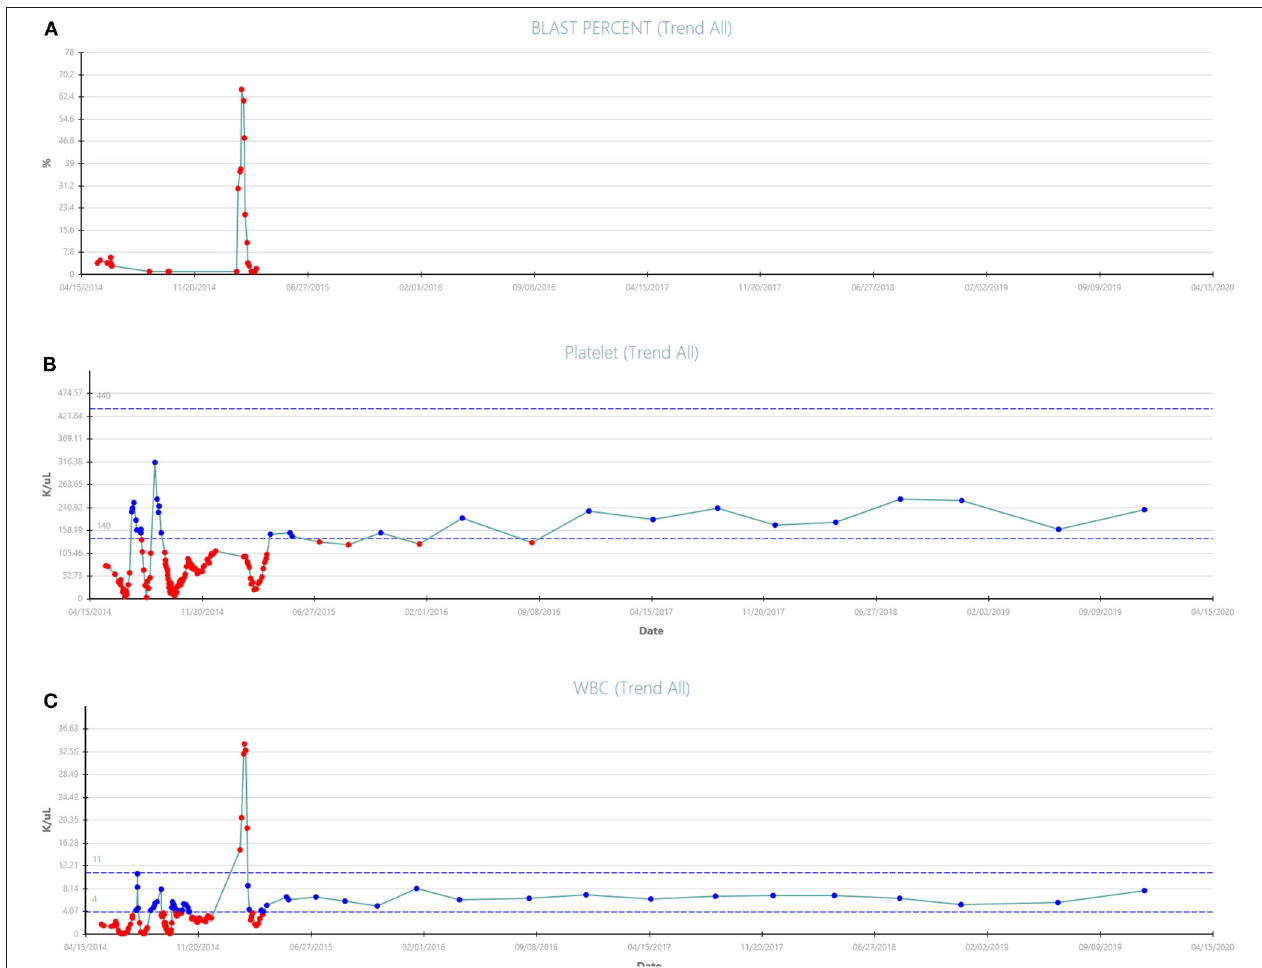
FIGURE 2 | (A–C) Updated trend of blast percentage, white blood count, and platelets from presentation in March 2015 to December 2019 with continuation of treatment with Vidaza + Sorafenib combination therapy for patient #1 are shown.